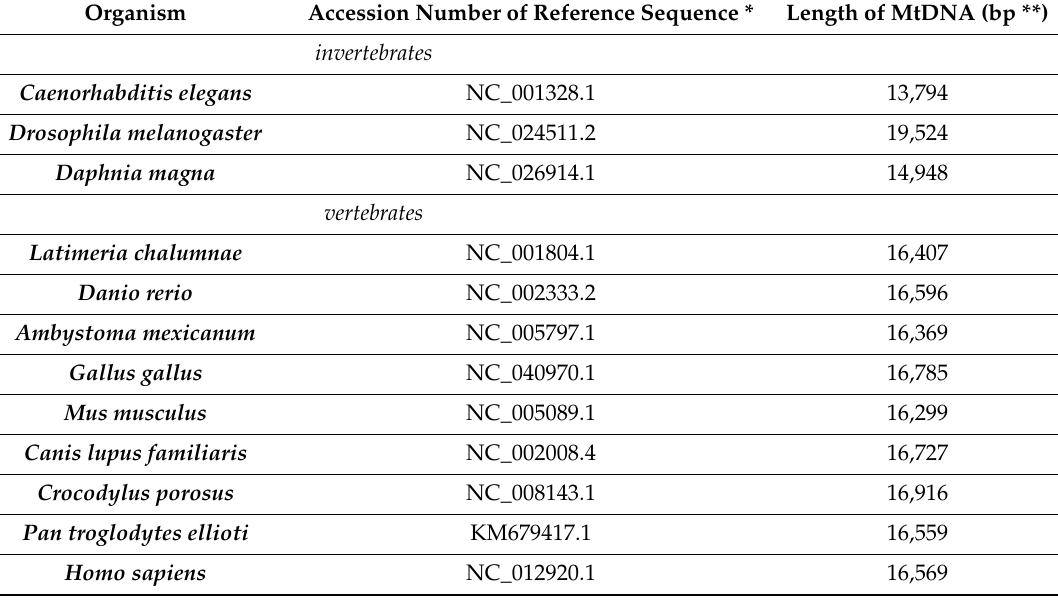
Table 1. MtDNA reference sequences of analysed model